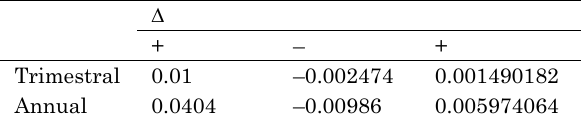
table 3. D rate of